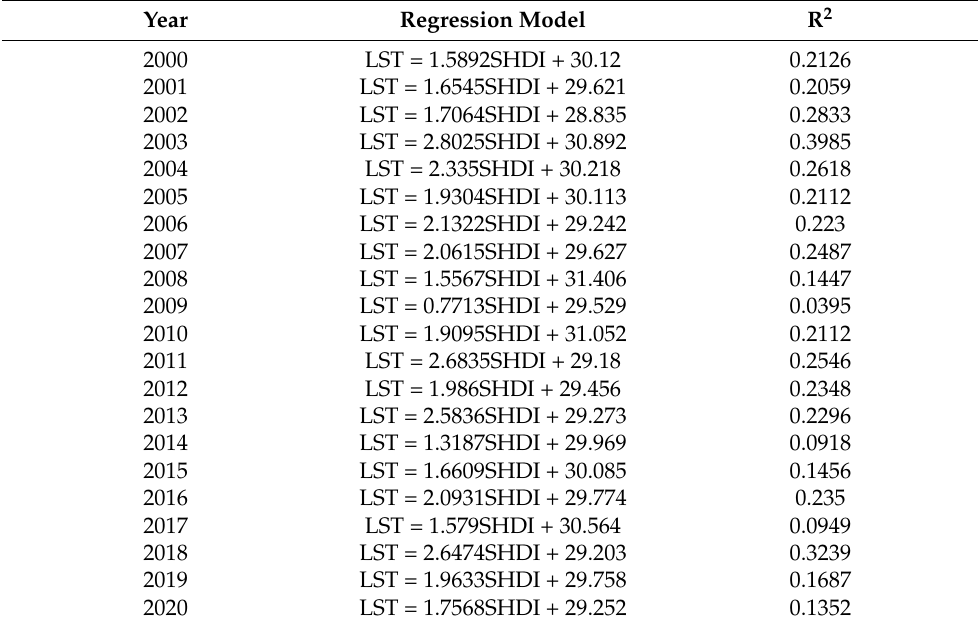
Table 5. Regression analysis of land use SHDI and LST from 2000 to